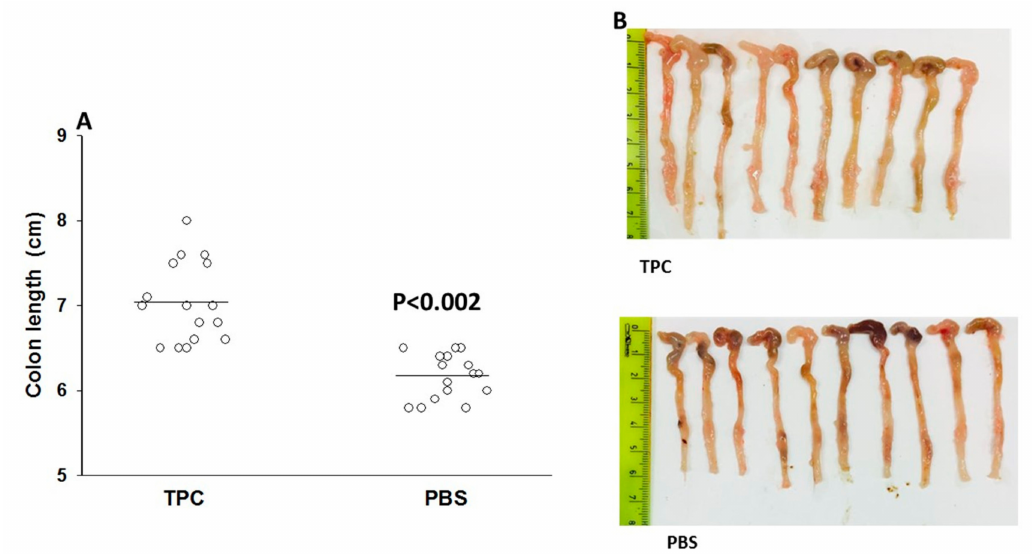
Figure 3. The e ff ect of tuftsin–phosphorylcholine (TPC) on colon length. Colon length measurements represented in centimeters, on Day 45 of experiment, after three cycles of 2% DSS and 15 days of treatment with TPC or phosphate-bu ff ered saline (PBS). ( A ) TPC-treated mice demonstrated significantly less shortening of the colon ( p < 0.002). ( B ) Comparison of the colon length between TPC treated mice and PBS subjected